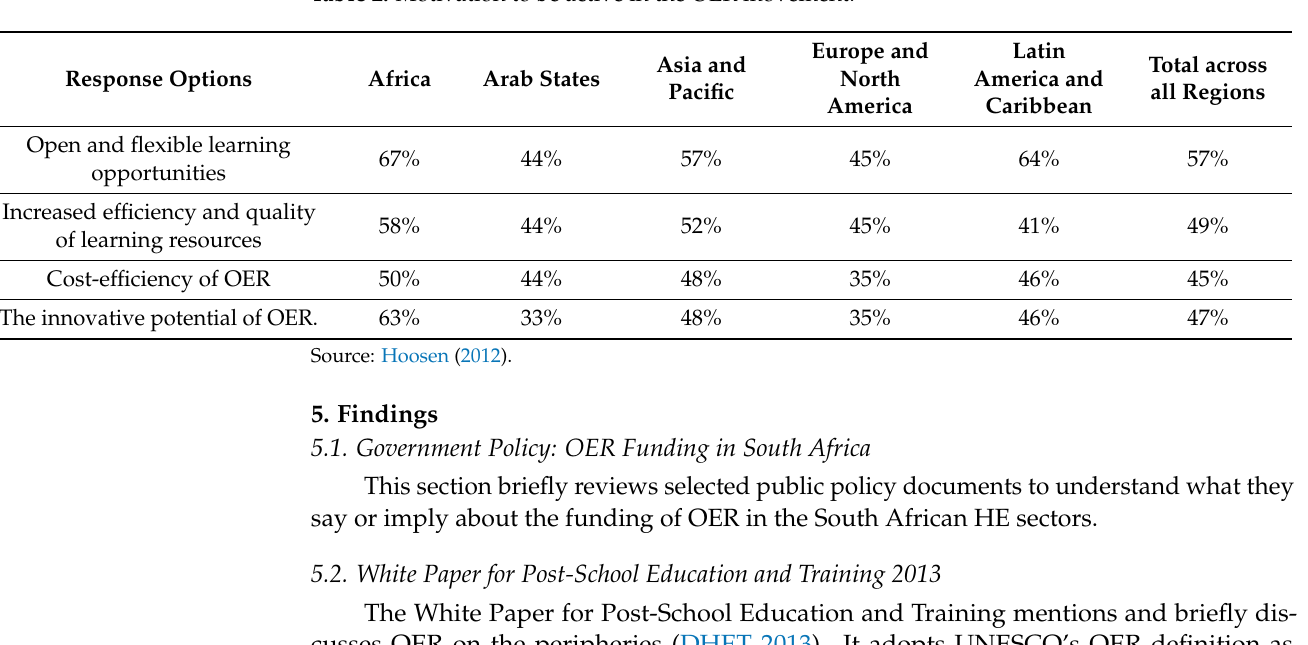
Table 2. Motivation to be active in the OER